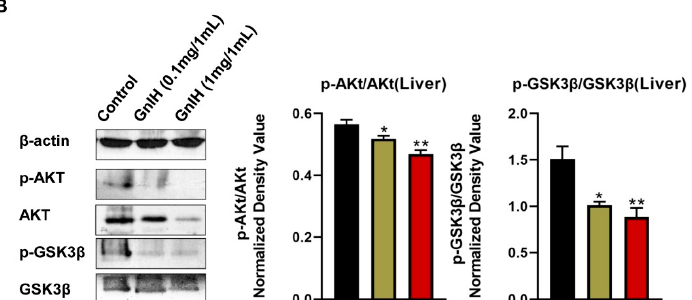
Figure 4. ( A ) The mRNA expression levels of hepatic glucometabolism ‐ related genes in intraperitoneally GnIH ‐ injected piglets. GCK as a key glycolysis enzyme, PEPCK and FBP1 as critical gluconeogenesis enzymes, GLUT4 as a key glucose transporter, IRS1 and IRS2 as insulin transduction factors were selected to detect by relative RT ‐ PCR. ( B ) Effect of intraperitoneally injected GnIH on AKT ‐ GSK3 β signaling in the liver of piglets administered different chronic doses of GnIH or vehicle. Densitometric quantification of p ‐ AKT and p ‐ GSK ‐ 3 β levels was performed after normalization to total AKT and GSK ‐ 3 β levels as loading controls, respectively. n = 3 independent experiments. The data are shown as the means ±SEM. * p < 0.05 and ** p < 0.01 . GnIH vs. vehicle.